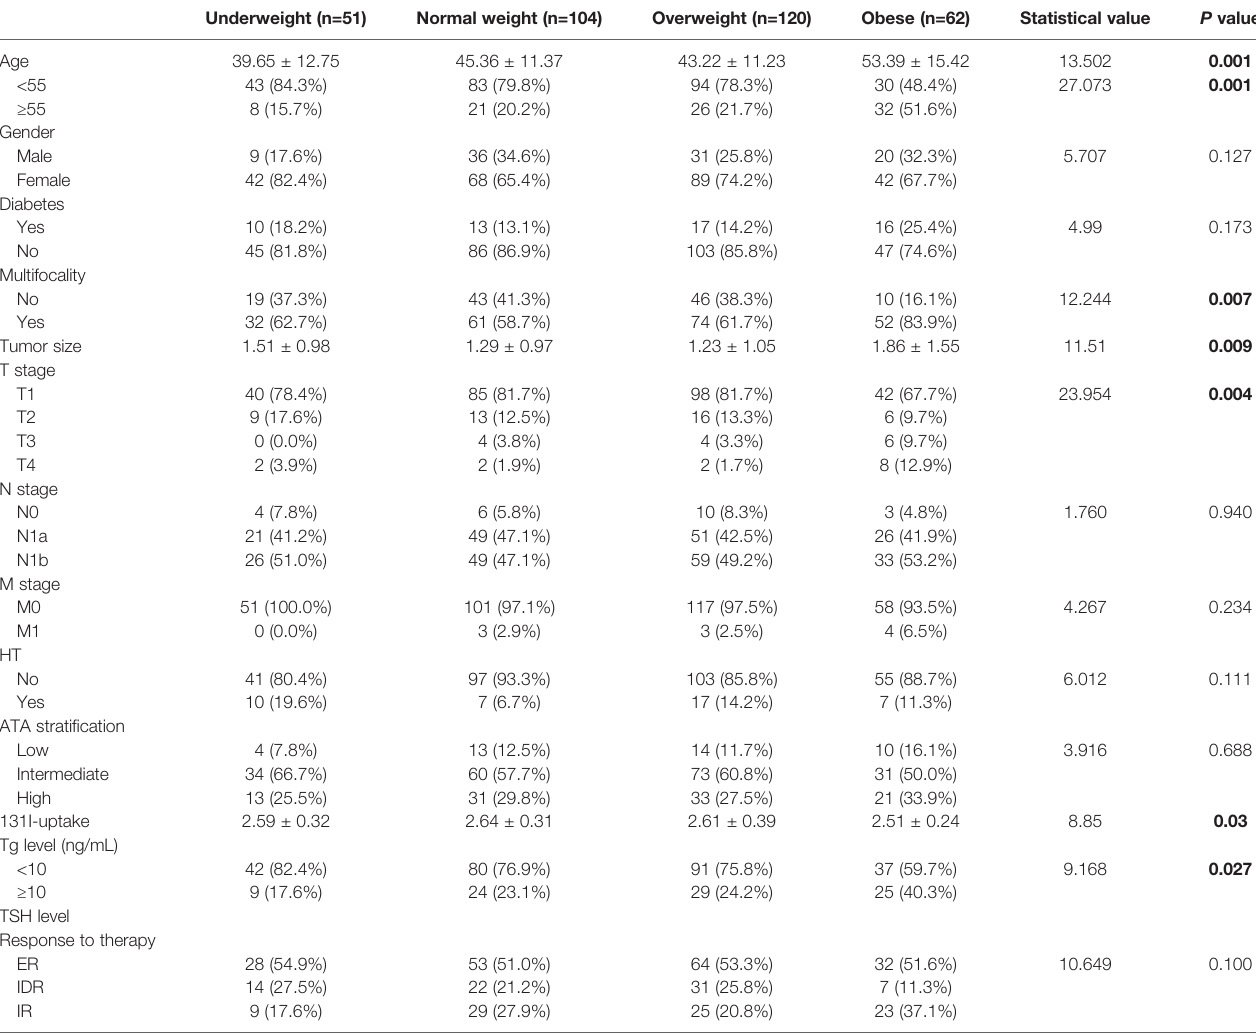
TABLE 2 | Demographic data and aggressive features in obese, overweight, normal weight, and underweight patients.